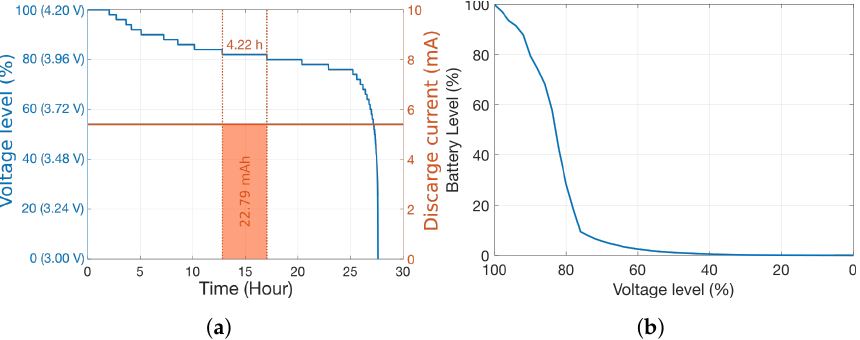
Figure 6. 150 mAh battery graphs, battery profile at constant drop-off current of 5.4 mA ( a ), and relation between voltage level (100% to 0%) and battery level (100% to 0%) ( b